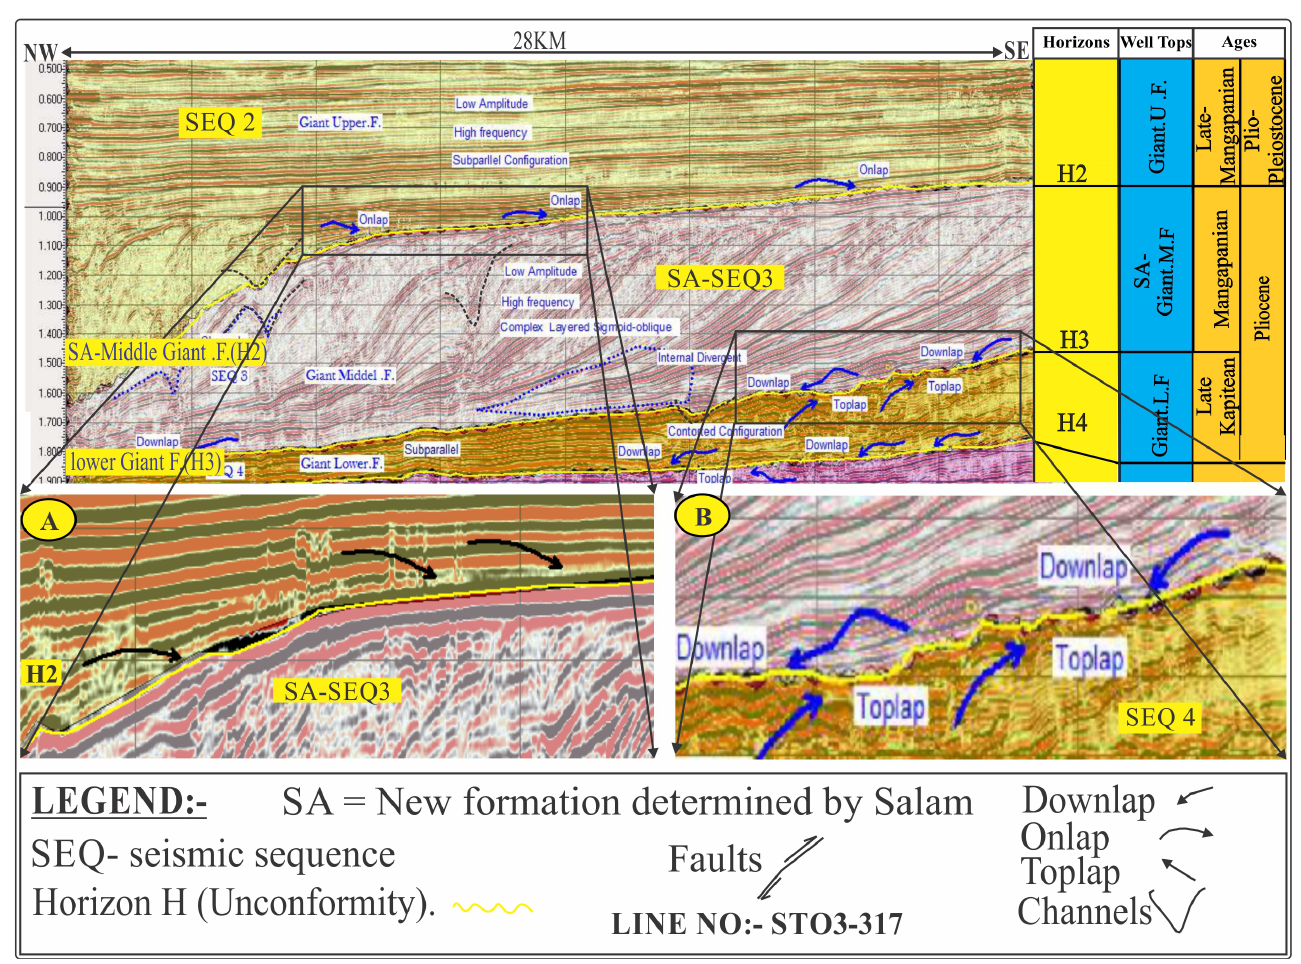
Figure 11. Interpreted seismic section showing the position of the newly identified Sequence, namely SA-SEQ2. A shows the onlapping reflection terminations over the new identified horizon, B shows the down lapping reflection terminations of the picked horizon